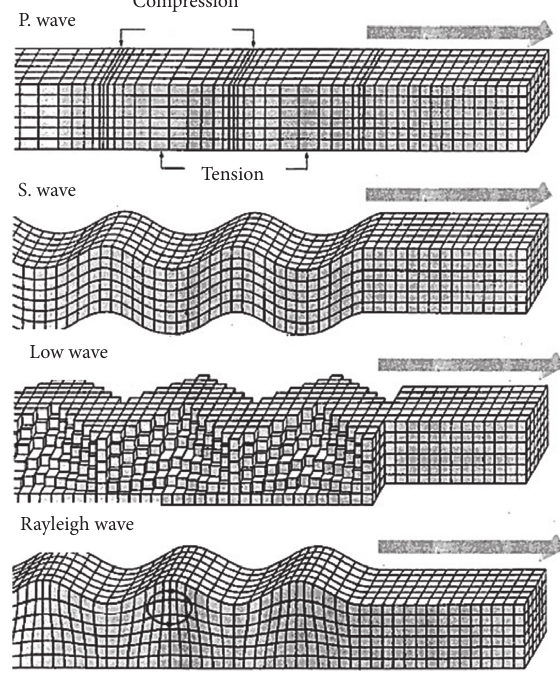
Figure 13: Comparing R and S waves in designing pipes.